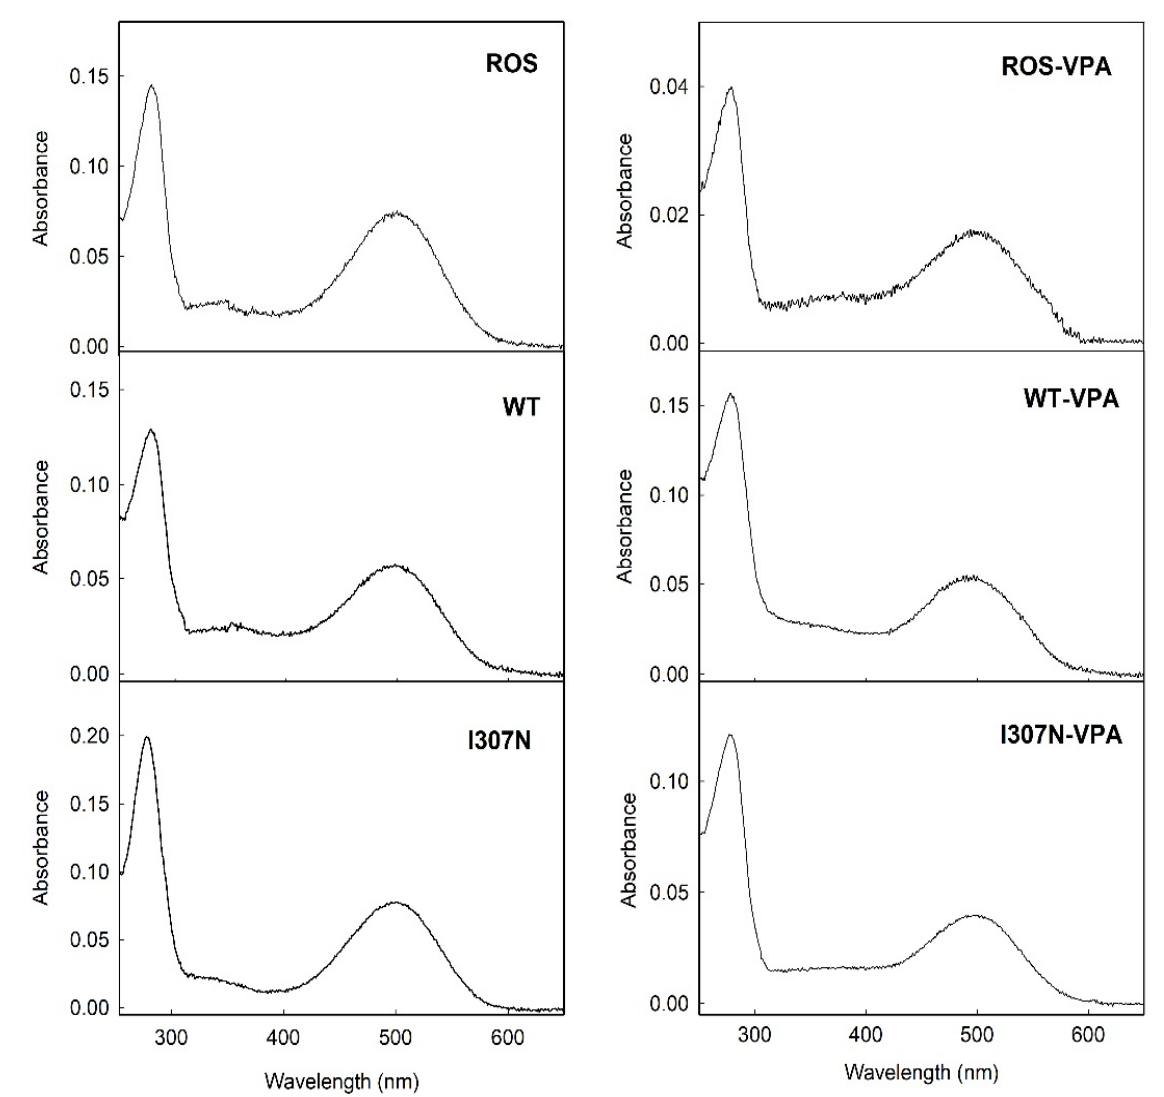
Figure 1. UV-vis absorption spectra of immunopurified ROS, WT, and I307N mutant Rhos, with and without VPA treatment, in the dark state. Samples are in buffer B (137 mM NaCl, 2.7 mM KCl, 1.5 mM KH 2 PO 4 , and 8 Mm Na 2 HPO 4 , pH 7.4, 0.05% DM). Spectra were recorded at 20 °C with the spectral parameters described under the Materials and Methods section. Table 1. UV-Vis Spectroscopy: UV-vis spectral parameters of ROS, WT, and I307N mutant Rhos, with and without VPA treatment, in the dark state.